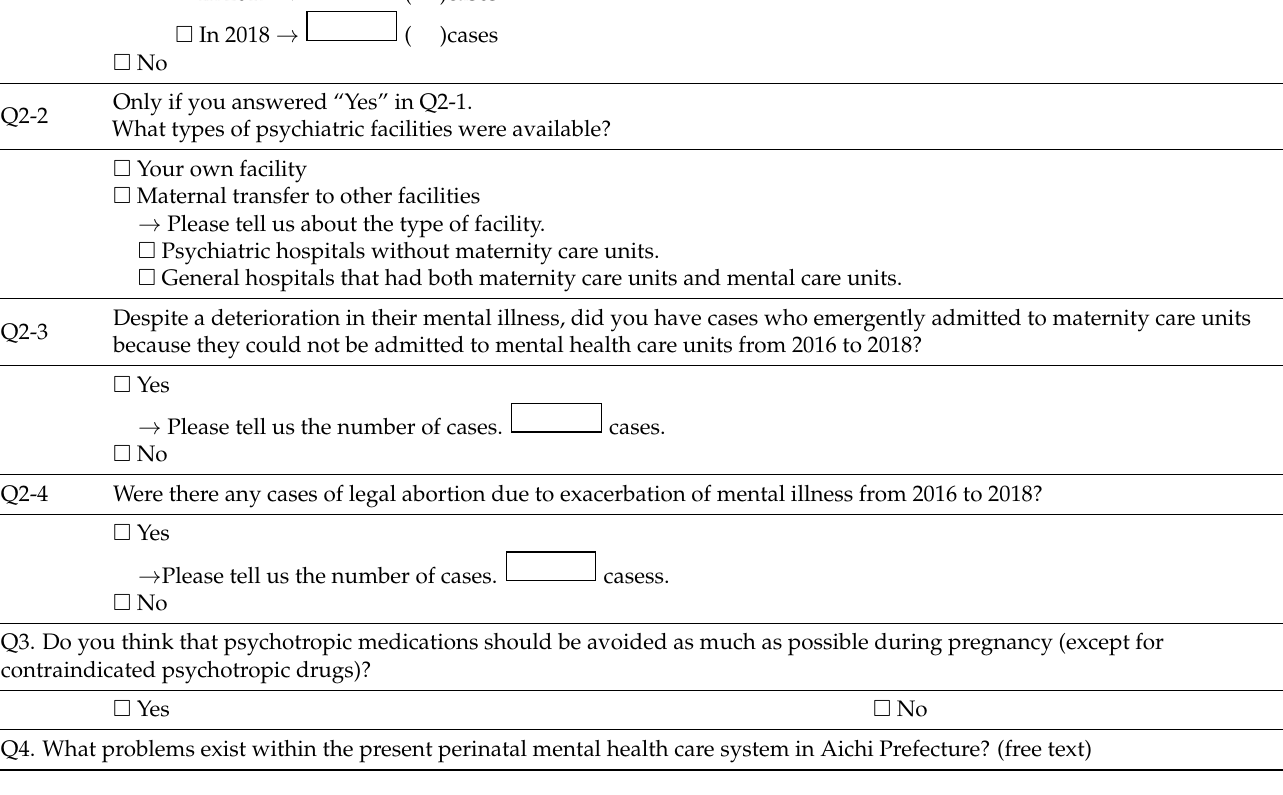
Table A1. Questionnaire for maternity care units.